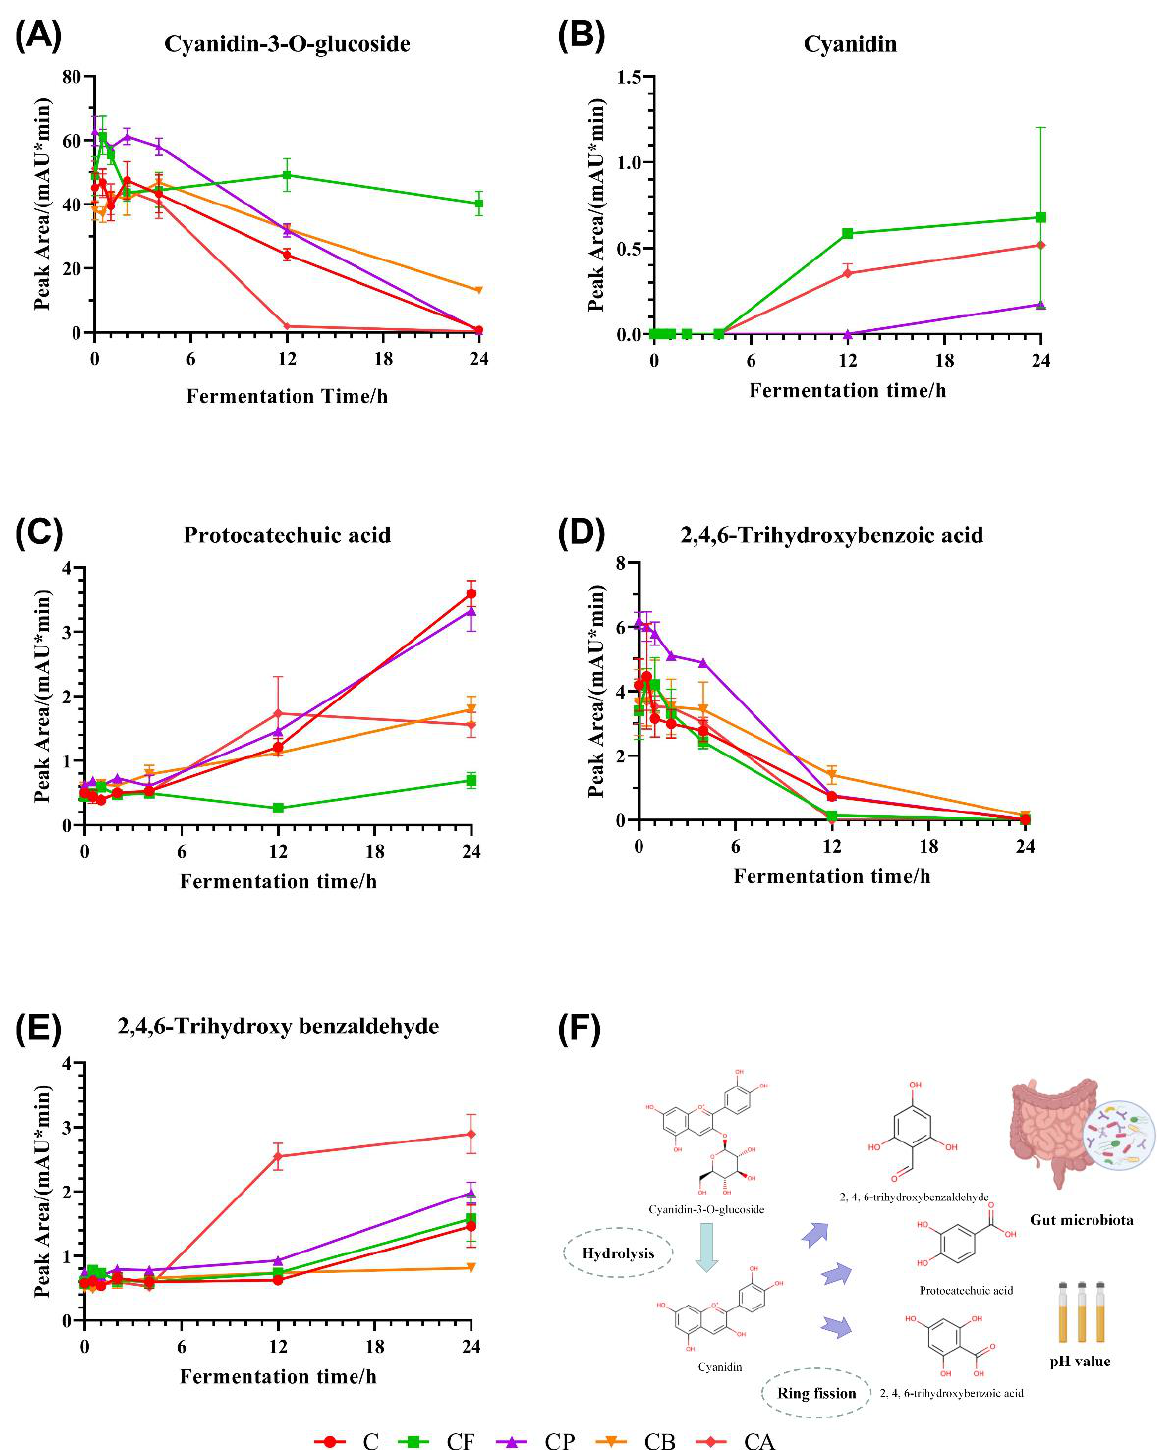
Figure 3. Changes in anthocyanin metabolites ( A ), Cyanidin-3-O-Glucoside ( B ), Cyanidin ( C ), PCA ( D ), 2,4,6- trihydroxybenzoic acid (TBA) ( E ), and (TB) during in vitro fermentation and the structural changes in metabolites ( F ). Cyanidin is the hydrolyzed product of the C3G glycosidic bond [38] (Figure 3F). The changes in the peak area for cyanidin in six groups of samples at seven time points after integration are shown in Figure 3B. Cyanidin was detected in the fermentation broth in only three of the six groups. Generally speaking, the changes in C3G and cyanidin should be inversely proportional; that is, the more cyanidin breaks away from the C3G glycosidic bond, the more cyanidin will be retained in the fermentation broth. However, the C3G peak area for the CF group was still relatively high after 24 h, and this phenomenon was also observed for the cyanidin peak area in the corresponding integral graph. Therefore, we speculate that the co-fermentation of FOS and C3G may have protective effects on both C3G and cyanidin. Although the C3G in the CB group was not totally consumed by gut